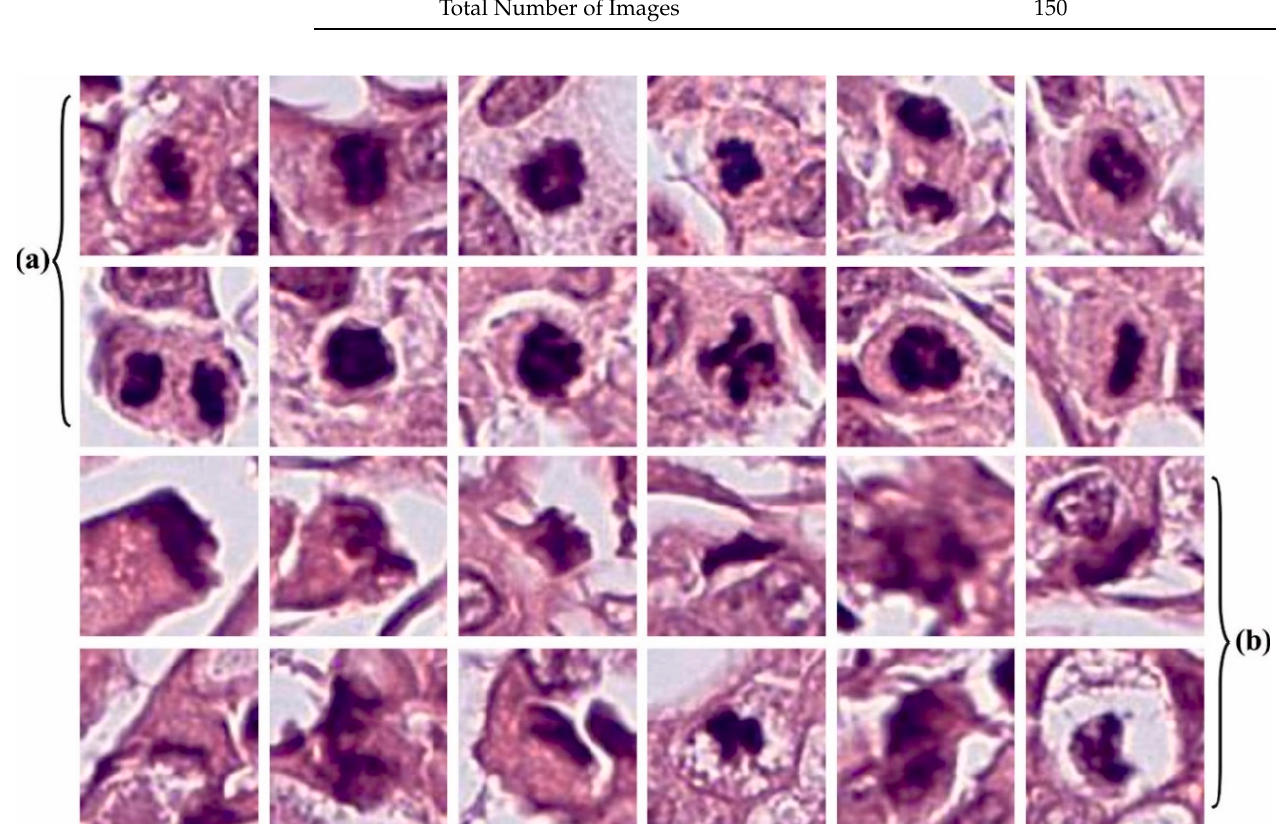
Figure 2. Sample images of ( a ) mitosis; ( b ) nonmitosis. The binary classification outcomes of the AHBATL-MNC method on the applied dataset are portrayed in the form of confusion matrix in Figure 3. On 60% of the training (TR) database, the AHBATL-MNC model detected 39 samples into mitosis class and 42 samples into nonmitosis class. Meanwhile, on 40% of the testing (TS) database, the AHBATL- MNC method detected 29 samples into mitosis class and 29 samples into nonmitosis class. Eventually, on 70% of the TR database, the AHBATL-MNC system detected 42 samples into mitosis class and 55 samples into nonmitosis class. Finally, on 30% of the TS database, the AHBATL-MNC algorithm detected 22 samples into mitosis class and 19 samples into nonmitosis